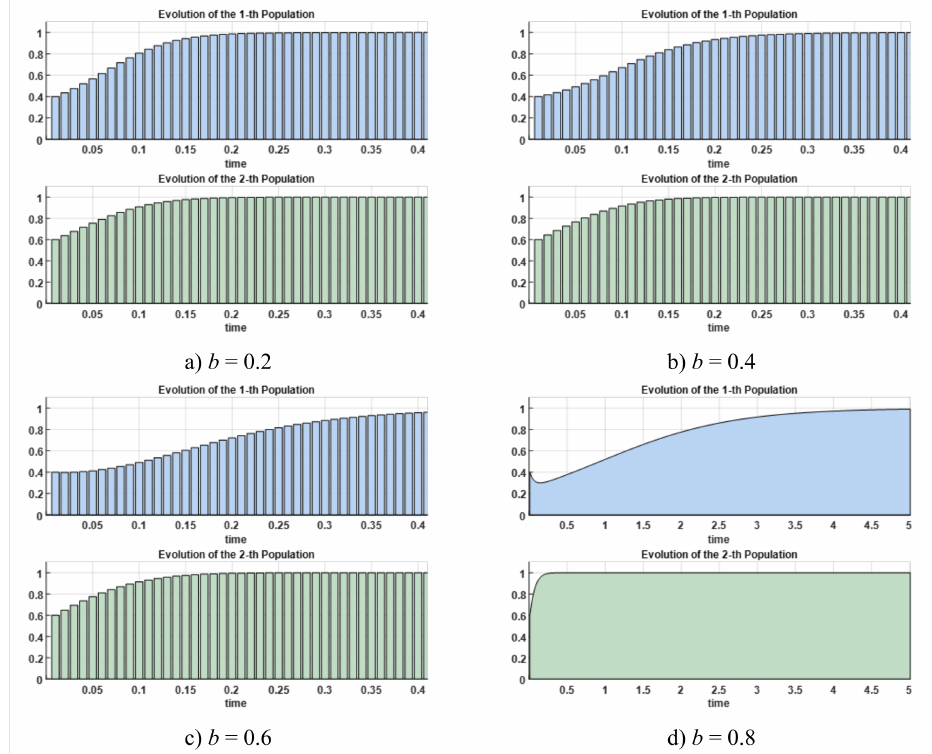
Figure 12. Influence of b change on system evolution (without government